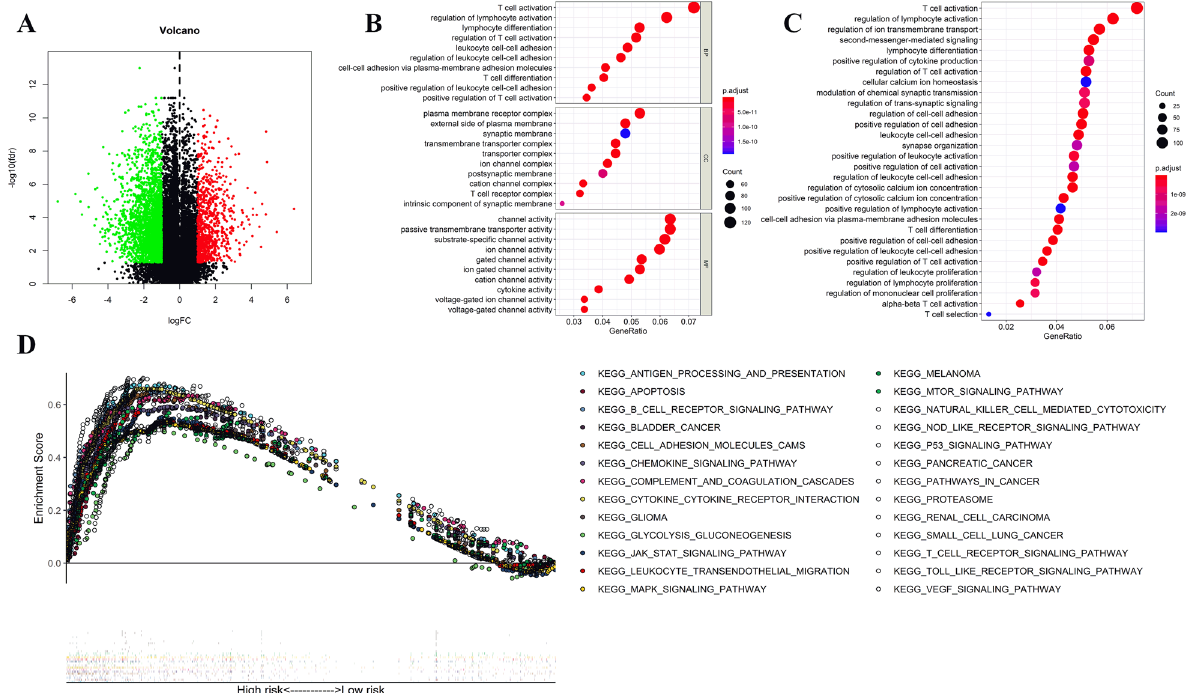
Figure 6. Function analysis. Volcano plot showing the differentially expressed genes between the low- and high-risk groups ( A ). Bubble graph for Gene Ontology (GO) enrichment ( B ). Bubble graph for Kyoto Encyclopedia of Genes and Genomes (KEGG) enrichment ( C ). Gene set enrichment analysis (GSEA) of the differentially expressed genes between high- and low-risk groups; The lower section represents that the further to the left the patient’s risk score increases, and the further to the right the patient’s risk score decreases ( D ). The figure was performed using R software (version 3.3.1, Vienna, Austria, https:// www.r- proje ct.